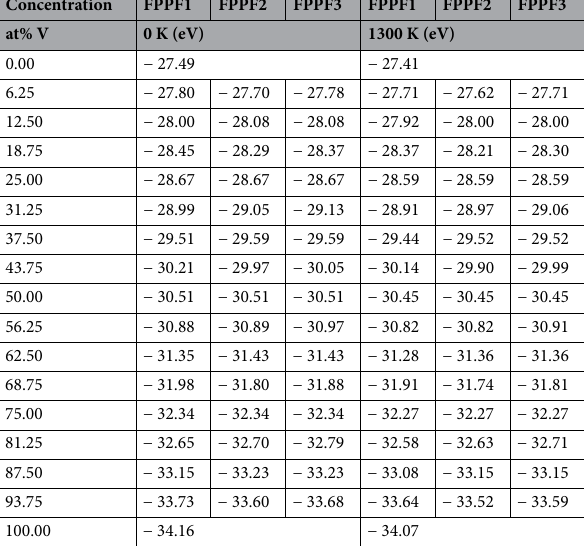
Concentration Random configurations (eV) CPF FPPF3 CPF FPPF3 at% V 0 K (cid:31) F ren (cid:31) F mix 1300 K 0 K 1300 K